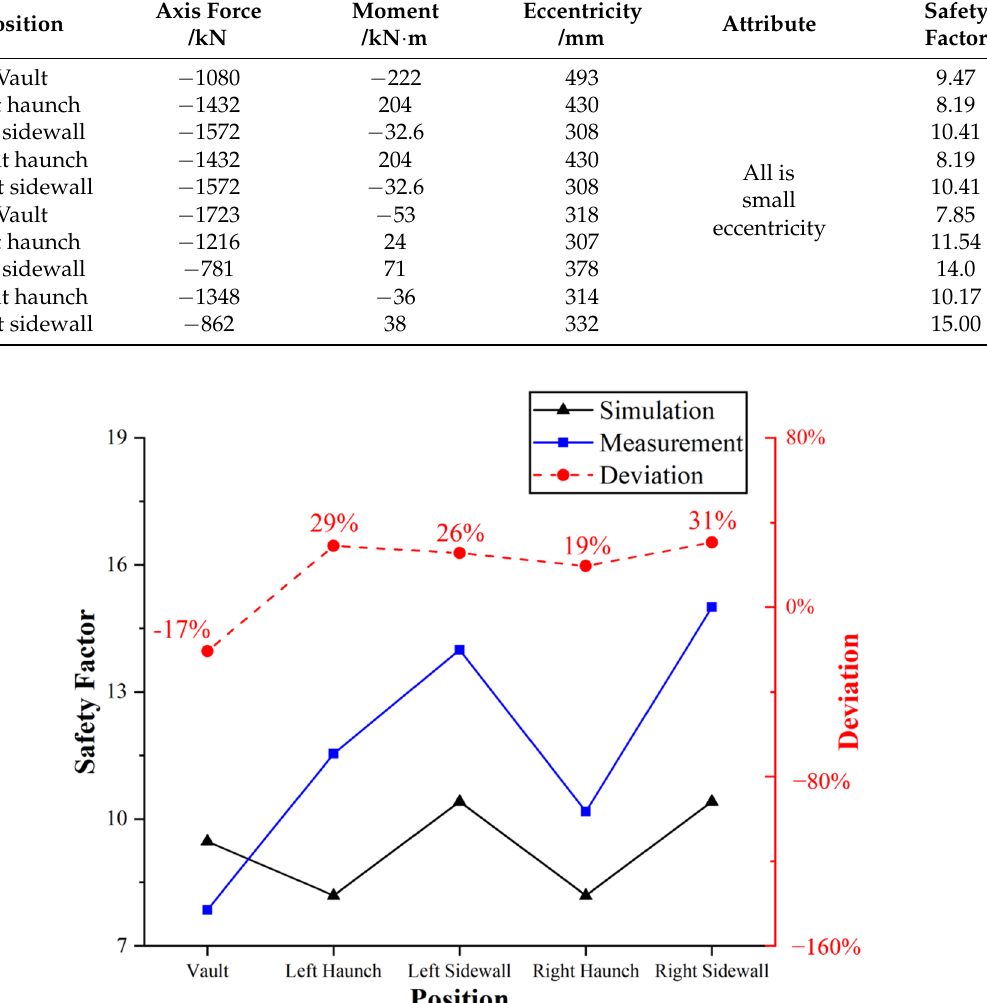
Figure 13. Safety factors of simulation and measurement. The deviation is about 25% averagely and mainly attributed to the efficiency of the rebar in secondary lining.